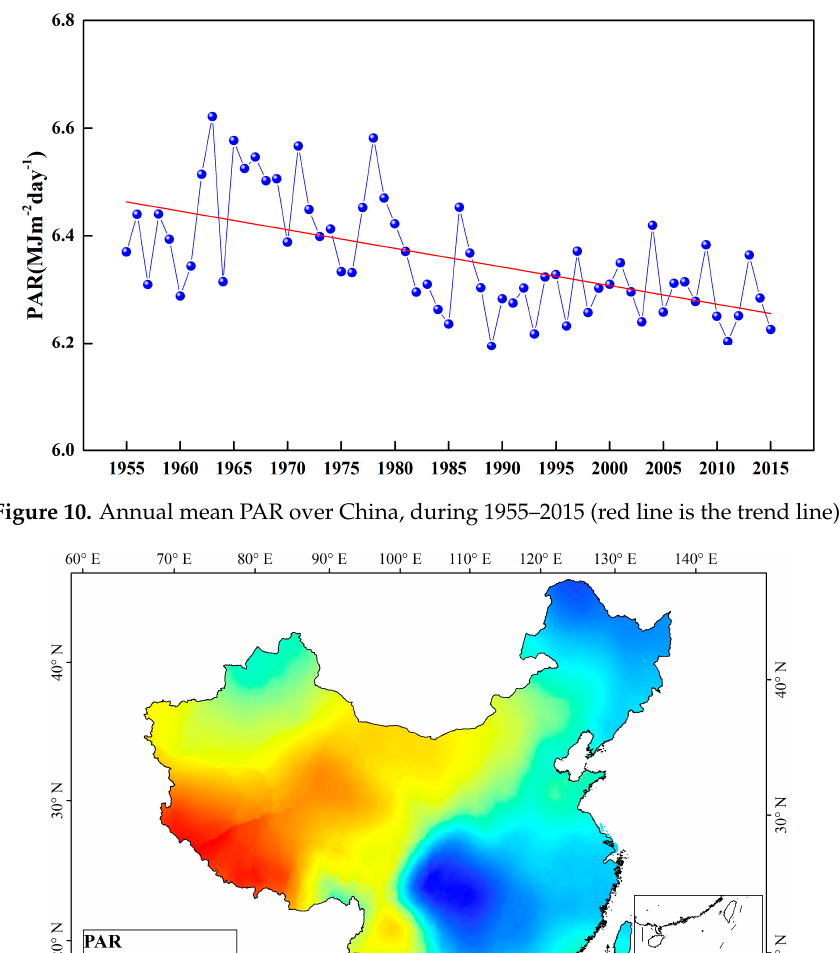
Figure 12. Spatial and temporal variations of PAR (MJ m − 2 day − 1 ) over mainland China; ( a ) January, ( b ) February, ( c ) March, ( d ) April, ( e ) May, ( f ) June, ( g ) July, ( h ) August, ( i ) September, ( j ) October, ( k ) November, and ( l ) December. 4. Conclusions The aim of this research was to make a comparative study on the model accuracies of ten models for estimating PAR over mainland China. The performances of the Genetic model, together with other nine PAR models, were evaluated in different climate zones and terrain features, using long-